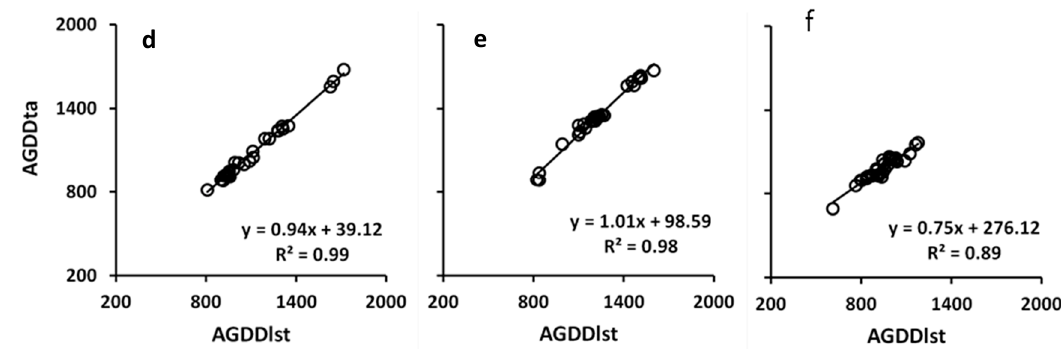
Figure 12. ( a – f ) Comparison of AMSR-E AGDDta at 95% of the initial peak VIs with the MODIS AGDDlst at 95% of the initial peak VIs in 2003. The panels span a latitudinal gradient: lowest latitude (Cherkessk, Russia ( a , d )), middle latitude (Sumy, Ukraine ( b , e )), and highest latitude (Kazan’, Russia ( c , f )) for 95% of the initial peak NDVI ( a–c ) and EVI ( d–f ). There is strong linear relationship between AGDDs from AMSR-E and MODIS at 95% of initial peak VIs for these sites in 2003 with r 2 ranging from 0.88 to >0.99. This strong positive relationship was consistent in space and time with r 2 ranging from 0.60 to >0.99 across all study sites and years.